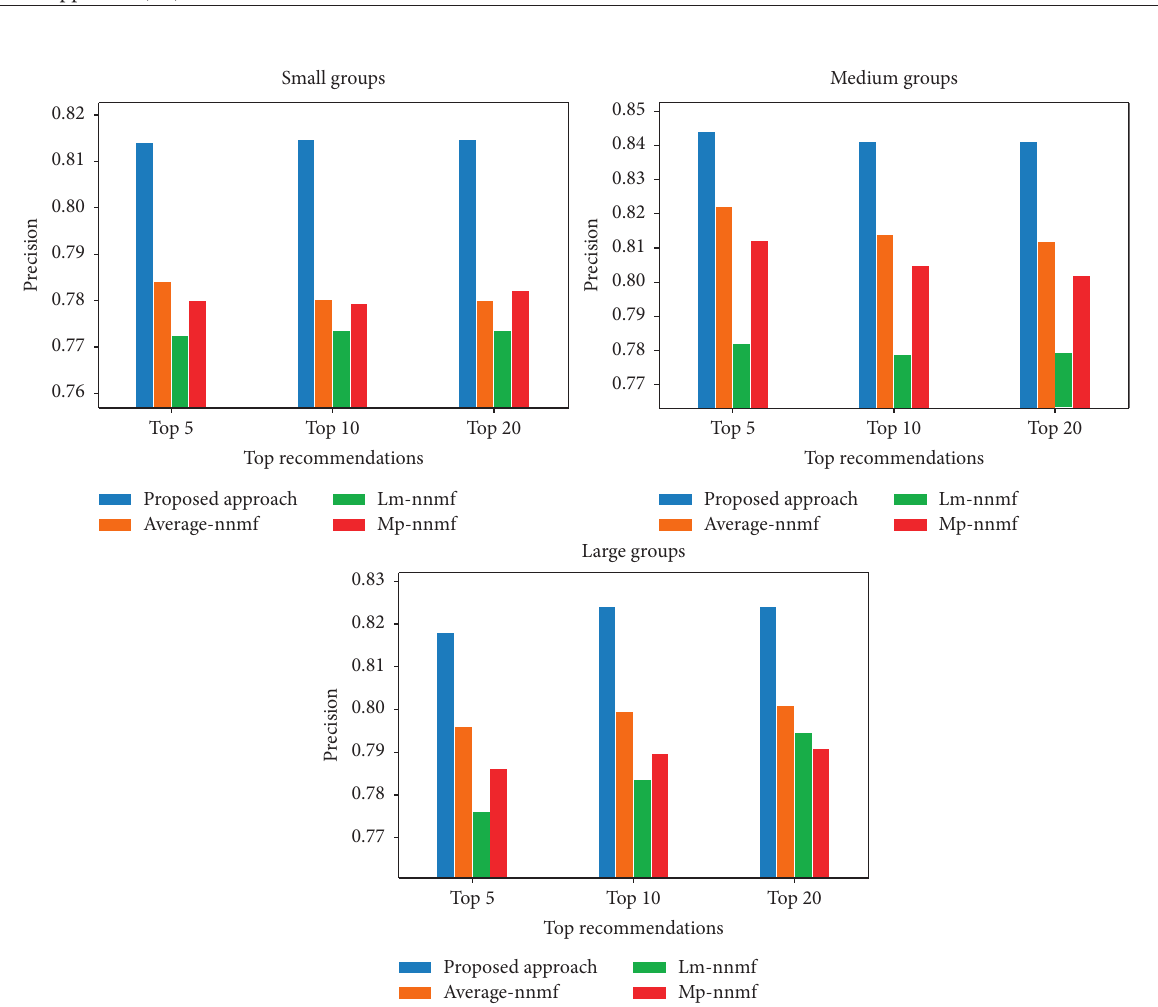
Figure 8: Precision of the three types of group recommendations’ evaluation.